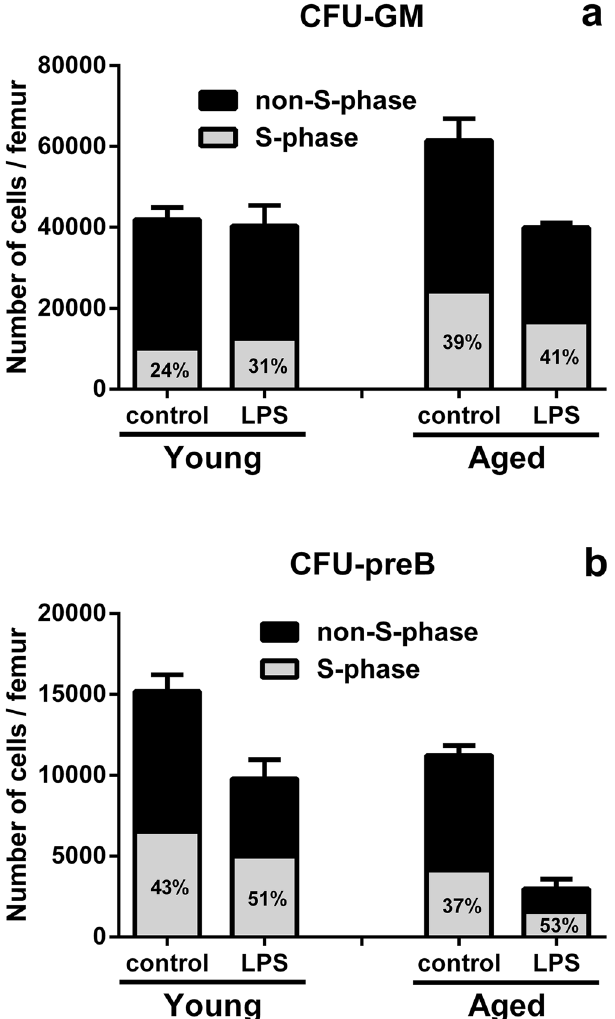
Figure 3. Changes in the proportion and the number of hematopoietic progenitor cells in S phase in the BM after LPS treatment. Changes in the proportion and the number of hematopoietic progenitor cells in S phase in the BM of young and aged SAMP1/TA-1 mice after LPS treatment are shown. The numbers (absolute and proportional) of S-phase CFU-GM ( a ) and CFU-preB ( b ) cells in young and aged SAMP1/TA-1 mice nine days after treatment with saline or 25 µg LPS are shown. The proportions of S phase CFU-GM and CFU-preB cells in young and aged mice are indicated as percentages in the bars. Femoral BM samples were obtained from three mice per group at nine days after treatment with saline or 25 µg LPS. Each bar represents the mean ±